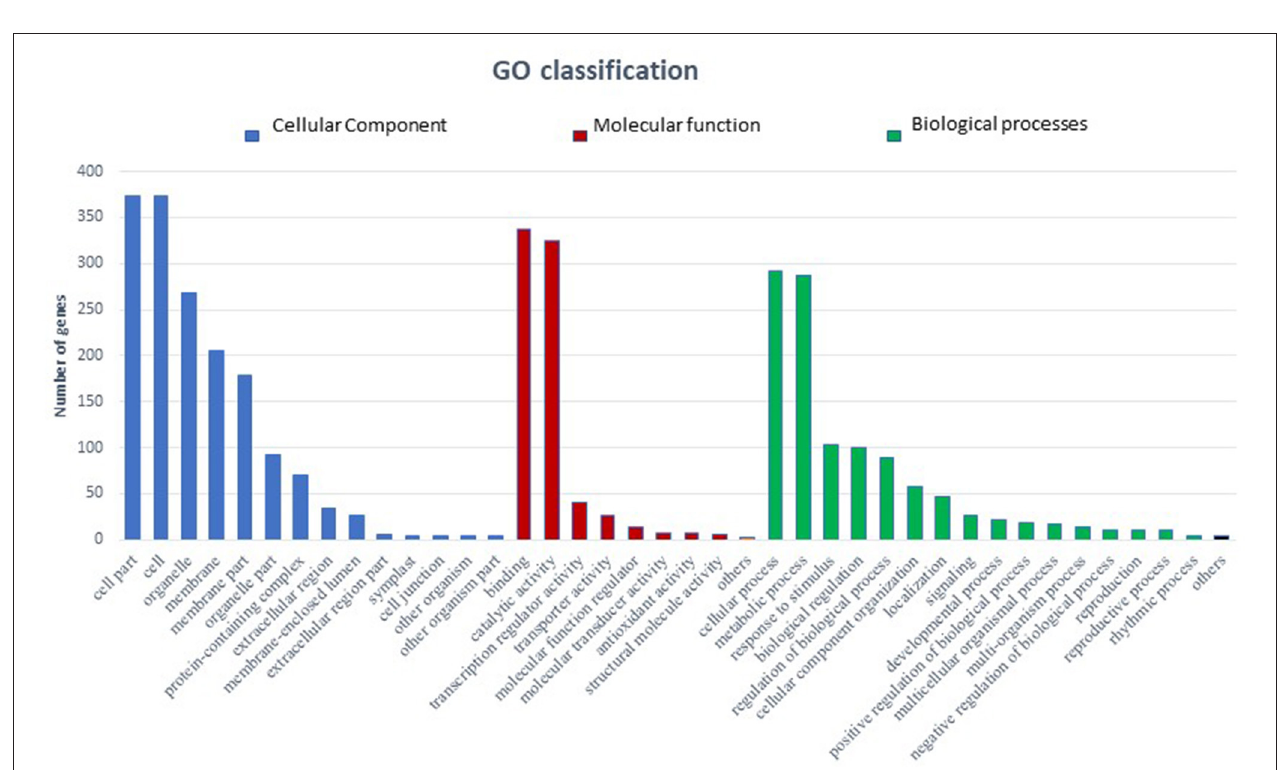
FIGURE 6 | Bar graph depicting the number of upregulated DEGs belonging to different Gene Ontology (GO) categories in tomato by GO enrichment analysis. (Blue bars represents cellular component category, red bars represents molecular function category, and green bars represents biological function category).